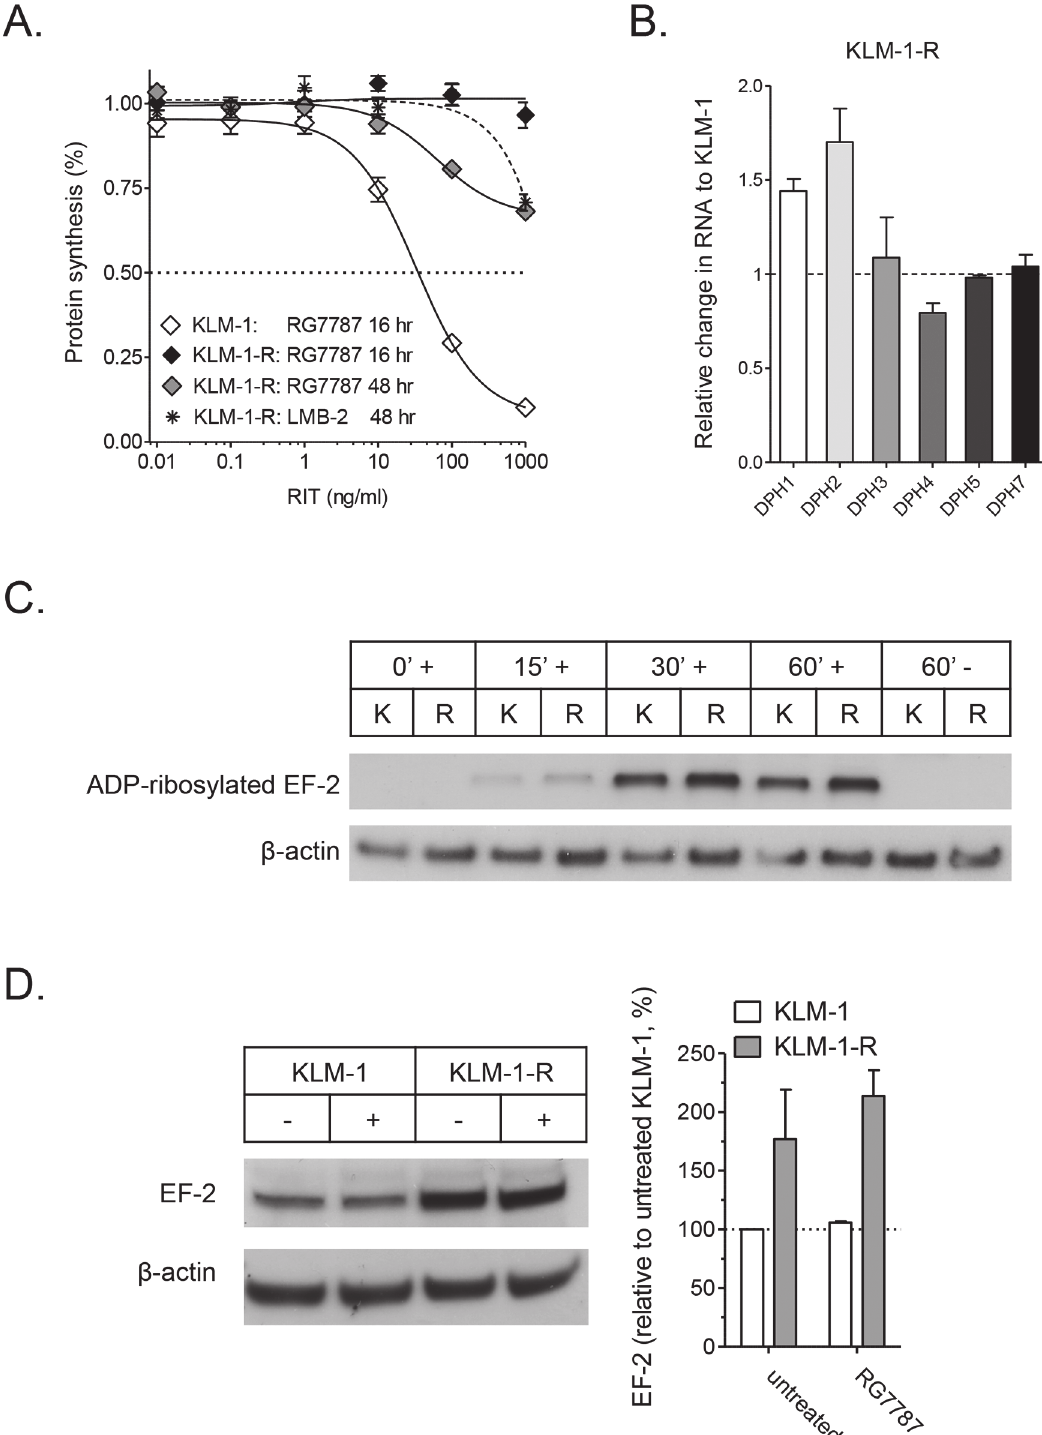
Fig 4. Protein synthesis inhibition and EF-2 ADP-ribosylation in KLM-1-R. A : Protein synthesis inhibition by RG7787 is limited in resistant KLM-1 (KLM- 1-R). KLM-1 was incubated for 16 hrs with RG7787, and KLM-1-R for 16 and 48 hrs with RG7787 and anti-CD25 LMB-2. RG7787 induces a dose-dependent protein synthesis inhibition in KLM-1-R, which is absent in KLM-1-R. After 48 hrs, RGG778 induces some decrease in protein synthesis in KLM-1-R, which is also the case with LMB-2. Protein synthesis inhibition was evaluated by measuring [ 3 H]leucine incorporation. B : Diphthamide Biosynthesis Protein (DPH) genes expression is not down-regulated in KLM-1-R, compared to KLM-1. Expression levels were evaluated with real time RT-PCR, standardized for ß-actin